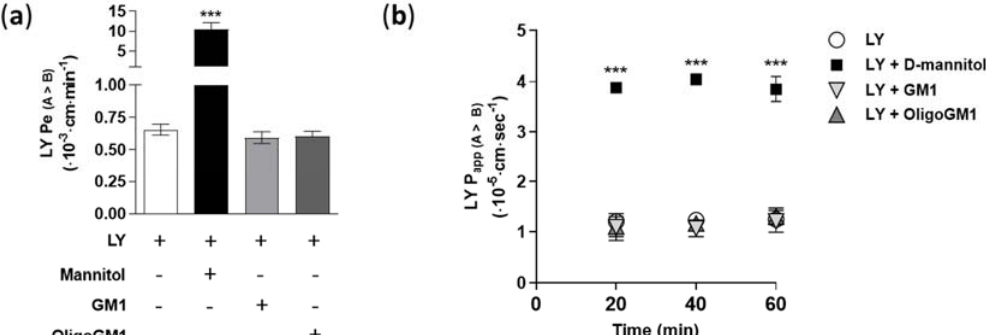
Figure 2. LY permeability coefficients through the hBLEC monolayer. ( a ) Direct transport ‐ related Pe values (A → B) ( × 10 − 3 cm/min) of 50 μ M LY alone or in combination with 50 μ M GM, 50 μ M OligoGM1, or 1.4 M D ‐ mannitol after 60 min. Comparable data obtained from 10, 100, and 300 μ M GM1 or OligoGM1 are shown in Table S1. Results are mean ± SEM from 4 independent experiments, which examined a minimum of 3 wells for each condition (*** p < 0.01 vs. LY, LY plus GM1, and LY plus OligoGM1, two ‐ way ANOVA, n = 4); ( b ) Direct transport ‐ related Papp values (A → B) ( × 10 − 5 cm/sec) of 50 μ M LY alone or in combination with 50 μ M GM1, 50 μ M OligoGM1, or 1.4 M D ‐ mannitol at different time points (20, 40, and 60 min) of hBLEC incubation. Results are mean ± SEM from 4 independent experiments ( n = 4), which examined a minimum of 3 wells for each condition (*** p < 0.01 vs. LY, LY plus GM1, and LY plus OligoGM1, two ‐ way ANOVA, n = 4).